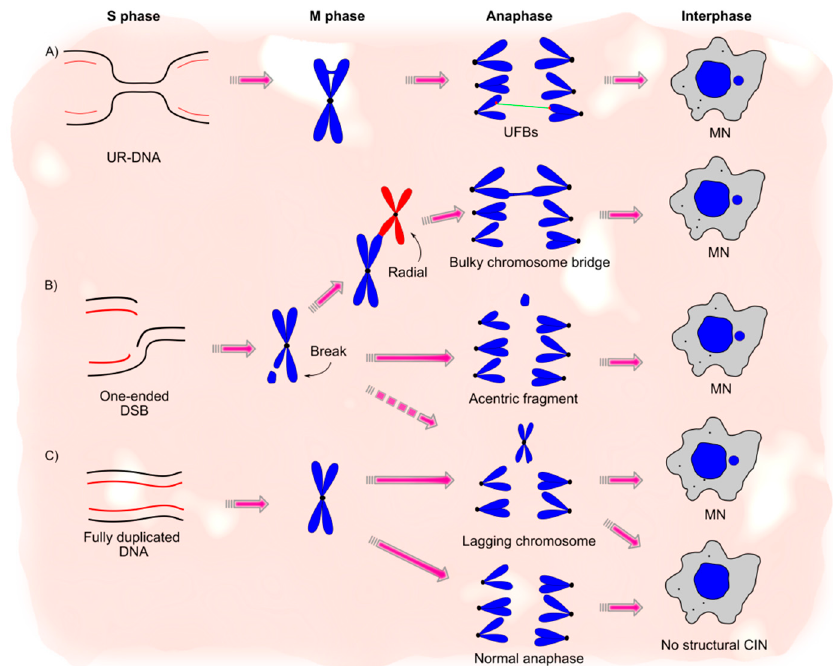
Figure 1. The multiple origins and tight associations of chromosome instability (CIN) phenotypes. ( A ) Under-replicated DNA (UR-DNA) formed during S phase and not resolved before mitosis leads to ultra-fine bridges (UFBs) when sister chromatids are pulled in opposite directions during anaphase. Breakage of these bridges can eventually lead to micronuclei (MN) formation in the following cell cycle. ( B ) Unrepaired one-ended double-strand breaks (DSBs) formed during S or M phase due to replication fork collapse can be visualized as chromosome breaks during mitosis. Improper repair of breaks by end-joining mechanisms can create fusions among non-homologous chromosomes, giving rise to radial chromosomes. Radial chromosomes form bulky chromosome bridges due to multiple centromeres and unequal pulling toward opposite poles. Similarly to UFBs, breakage of these bridges can also lead to MN formation. Breaks that are not fixed and lack a centromere give rise to acentric fragments, while breaks that activate the DNA damage response and DNA repair during mitosis (dotted arrow) can form lagging chromosomes. Both acentric fragments and lagging chromosomes are well known sources of MN. ( C ) Fully duplicated chromosomes mostly lead to normal cell division in mitosis and absence of structural CIN. However, under certain circumstances, they can experience lagging at the metaphase plate during anaphase, usually due to kinetochore-microtubule attachment problems. These lagging chromosomes can form whole chromosome micronuclei in the next cell